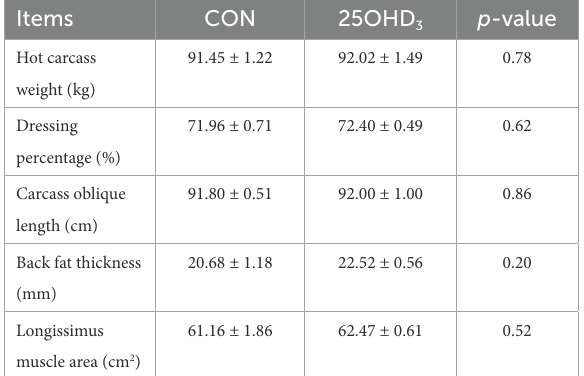
Figure 5. The Venn analysis identified 343 and 387 unique OTU in the CON and 25OHD 3 groups, respectively, of which 1,575 were shared OTUs between the two treatments (Figure 5A).